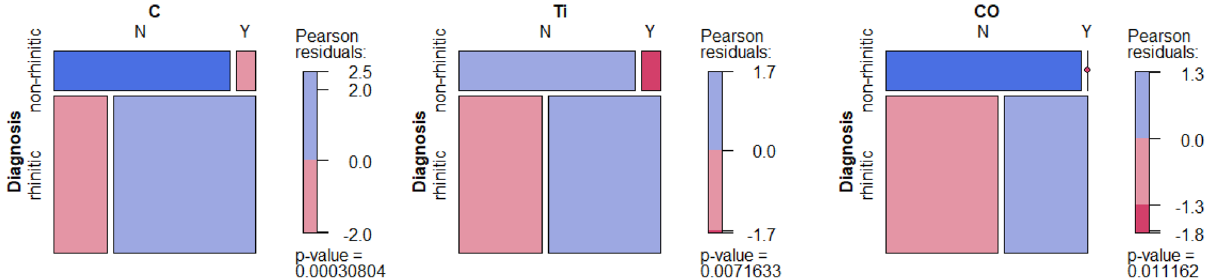
Figure 3. Mosaic plots of C, Ti, and CO association with the diagnosis. Red—underrepresented category, blue—overrepresented